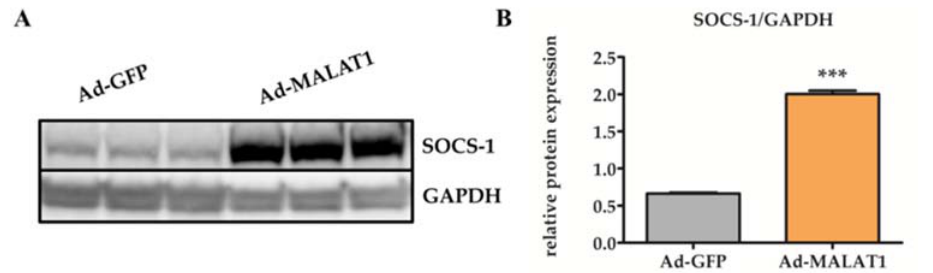
Figure 5. Overexpression of MALAT1 promoted the expression of suppressor of cytokine signaling-1 (SOCS-1) in the murine lungs after smoke exposure. Mice were transfected by Ad-GFP or Ad- MALAT1 by intratracheal nebulization and sacrificed one day after smoke inhalation. ( A ) Western blot to analyze SOCS-1 expression in the lungs of mice transfected with Ad-GFP or Ad- MALAT1 and exposed to smoke. ( B ) Densitometric quantification of the Western blots. Data are represented as means ± SEM ( n = 6). *** p < 0.01 vs. Ad ‐ GFP group.